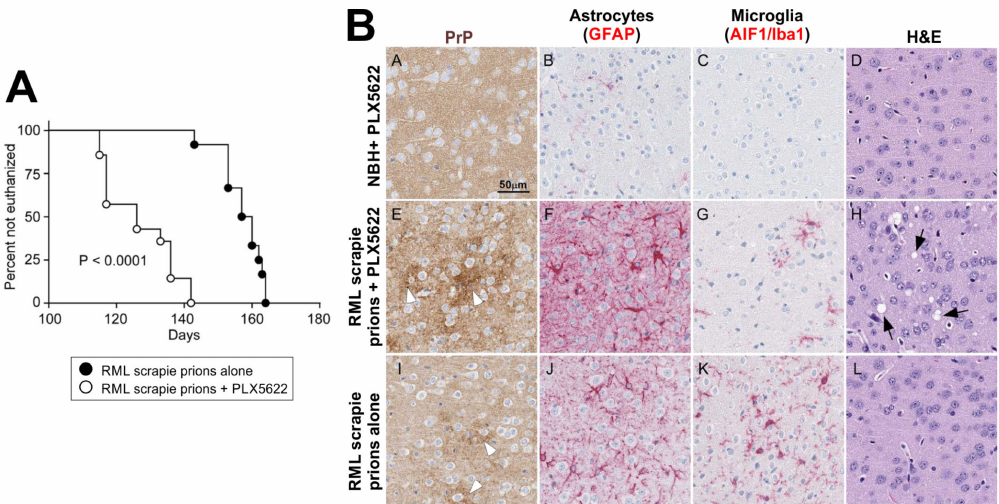
Figure 5. Accelerated CNS prion disease in the absence of microglia. ( A ) Survival curve shows enhanced onset of clinical prion disease in mice treated with the CSF1R-targeting kinase inhibitor PLX5622. ( B ) Immunohistochemical analysis shows increased PrP accumulation (brown), reduced abundance of microglia (AIF1 / Iba1 + cells, red), increased reactive astrocyte activation (GFAP + cells, red) andprion-specificvacuolation(arrows, H&Epanel)inPLX5622-treatedmiceat100daysafterICinjection with RML prions. Adapted with permission from the American Society for Microbiology from [160] ( J. Virol. 2018;92:e00549-18, https: // doi.org / 10.1128 /